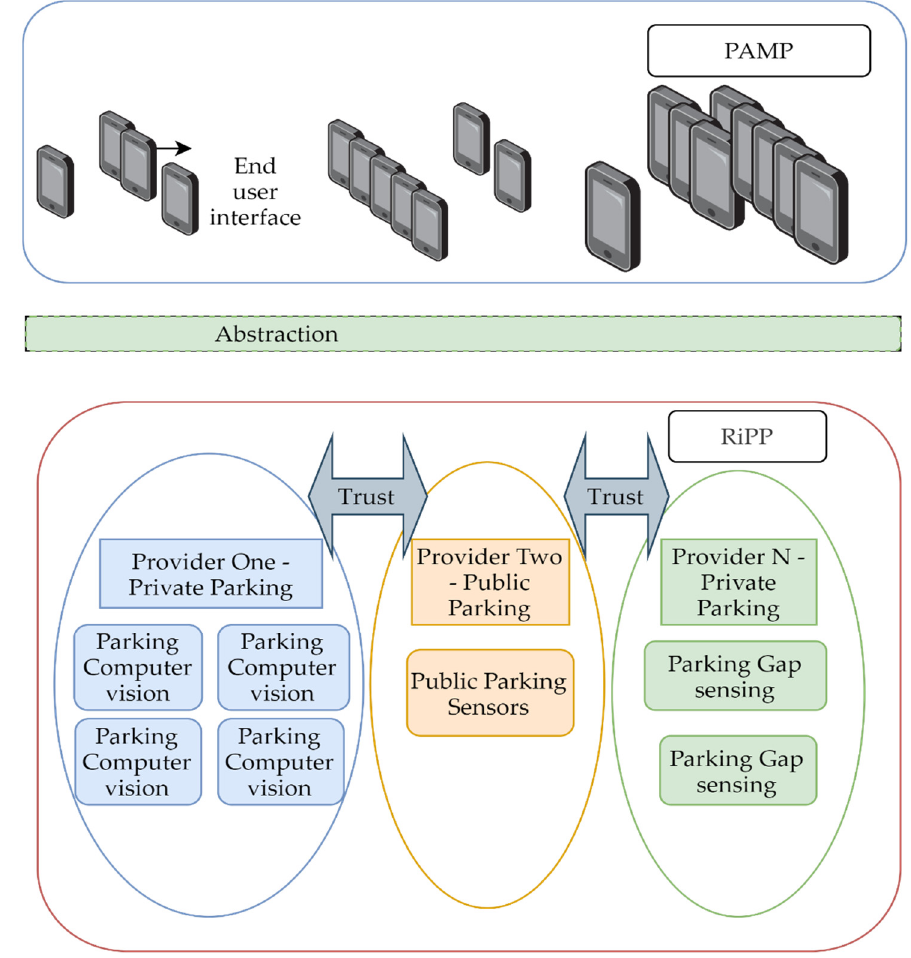
Figure 4. Federated smart parking model.